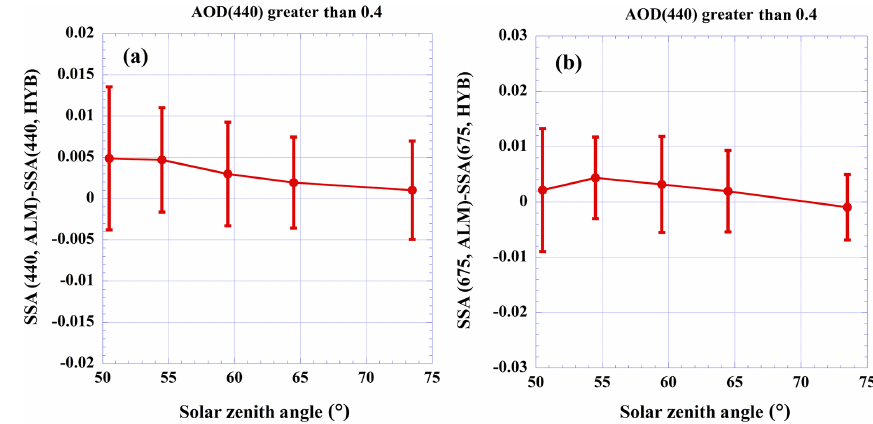
Figure 17. Difference in SSA retrieved from HYB and ALM scans. (a) 440; (b) 675nm.